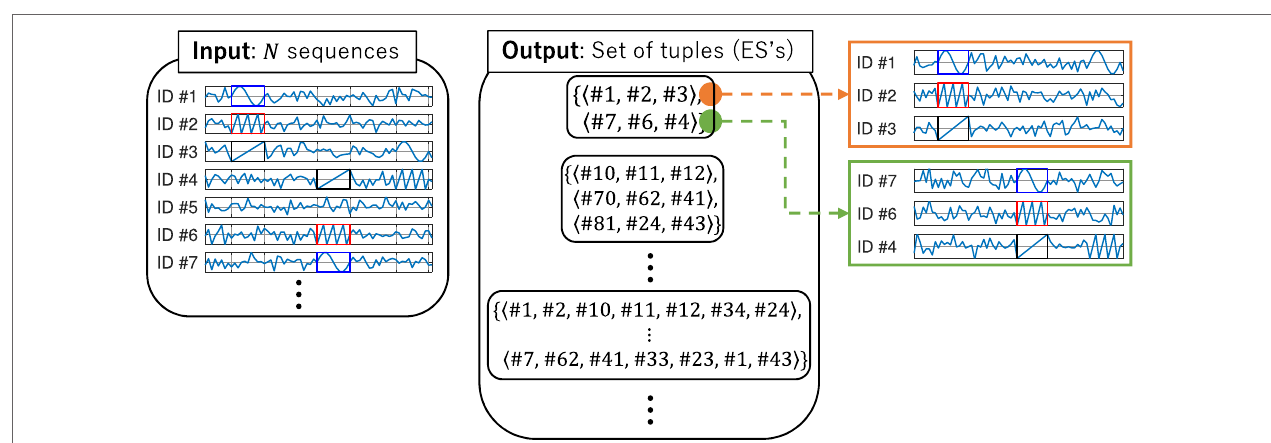
FIGURE 1 | An illustration of the input and output of equivalence structure (ES) extraction. The left figure shows the input, and the center figure shows the output. The right figure shows an example of an ES where the elements are tuples ⟨ #1, #2, #3 ⟩ and ⟨ #7, #6, #4 ⟩ . A subsequence of a three-dimensional sequence specified by one of the tuples closely resembles that by the other